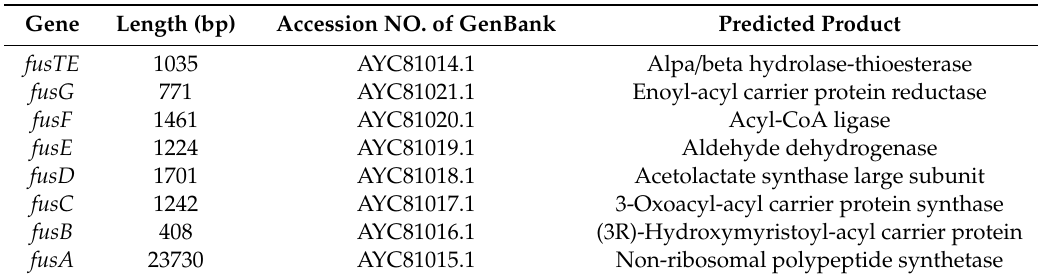
Table 1. Name, length, and predicted function of genes within the fus gene cluster of P. polymyxa WLY78.